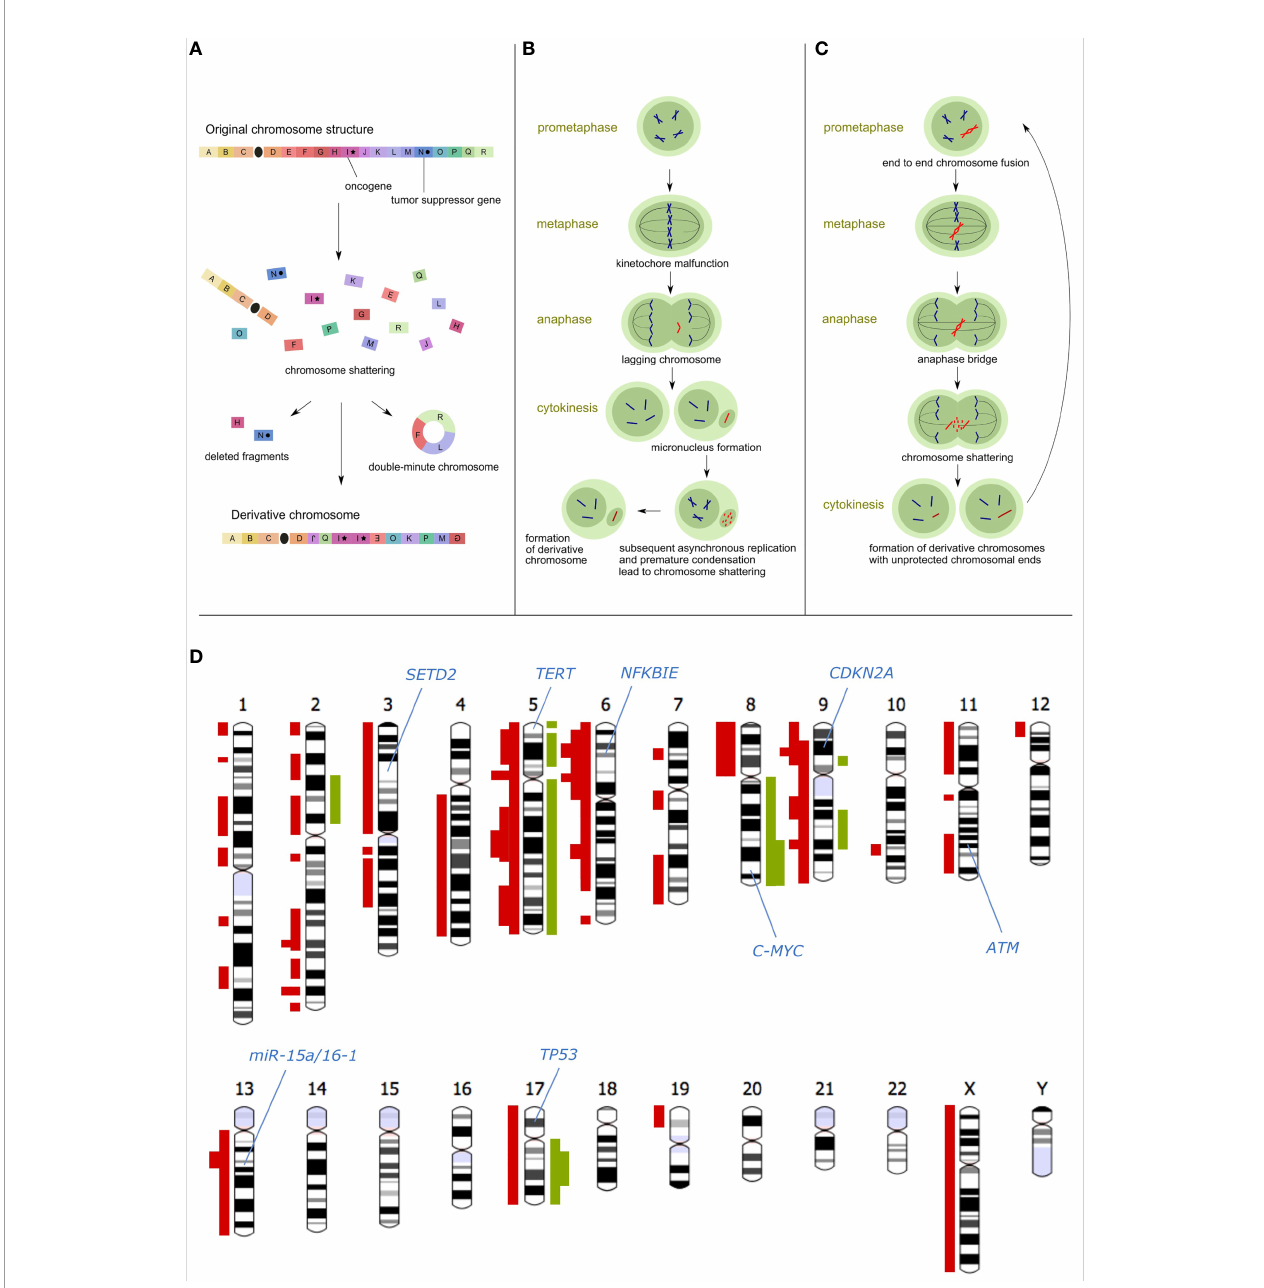
FIGURE 1 | Causes and consequences of chromothripsis. (A) Schematic model of chromosome shattering and reassembly via cth: After chromosome fragmentation, some regions are incorporated (possibly in multiple copies) into a derivative chromosome, whereas other regions can be lost or fused to episomal structures called double-minute chromosomes. (B) The micronuclei hypothesis of the cth origin: Chromosomes that are missegregated during cell division are entrapped in the micronucleus, followed by asynchronous replication compared to the main nucleus. This leads to premature chromosome condensation and shattering. Rejoining of fragments gives rise to the derivative chromosome which can subsequently be reincorporated into the main nucleus. (C) The origin of cth due to breakage-fusion- bridge (BFB) cycles and telomere crisis: Chromosome ends that become unprotected due to telomere shortening are fused into a dicentric chromosome containing two centromeres. In the subsequent cell cycle, this unstable structure is pulled to opposite spindle poles forming an anaphase bridge between the two daughter cells. The rupturing bridge generates two new unprotected chromosomal ends and initiates a new round of the BFB cycle. This repeats until the derivative chromosome becomes stable. (D) Chromosomal ideograms with cth-derived gains (green) and losses (red) observed in the following CLL studies: Stephens et al., 2011 (5); Edelmann et al., 2012 (3); Pei et al., 2012 (16), Bassaganyas et al., 2013 (17); Salaverria et al., 2013 (18); Tan et al., 2015 (19); Parker et al., 2016 (20); Leeksma et al., 2021 (2). The thickness of the highlighted loci corresponds to the number of studies referring to the respective regions affected by cth. Only studies mentioning speci fi c affected areas and distinguishing individual patients were